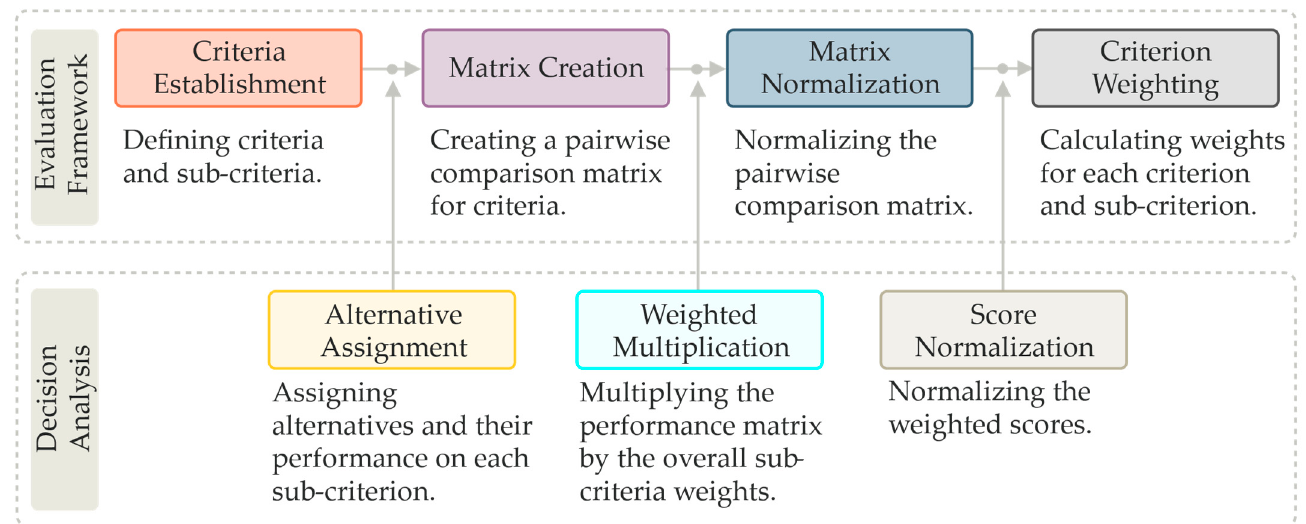
Figure 6. The two-stage decision-making process consists of the evaluation framework and decision analysis.